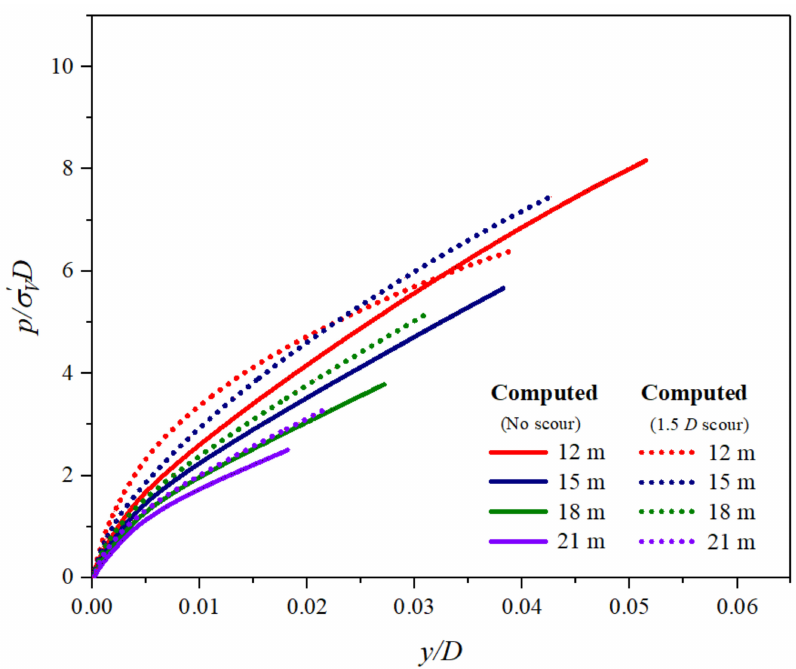
Figure 7. Load displacement characteristics of piles at different depths in S d 2 = 1.5 D ( 9 m )